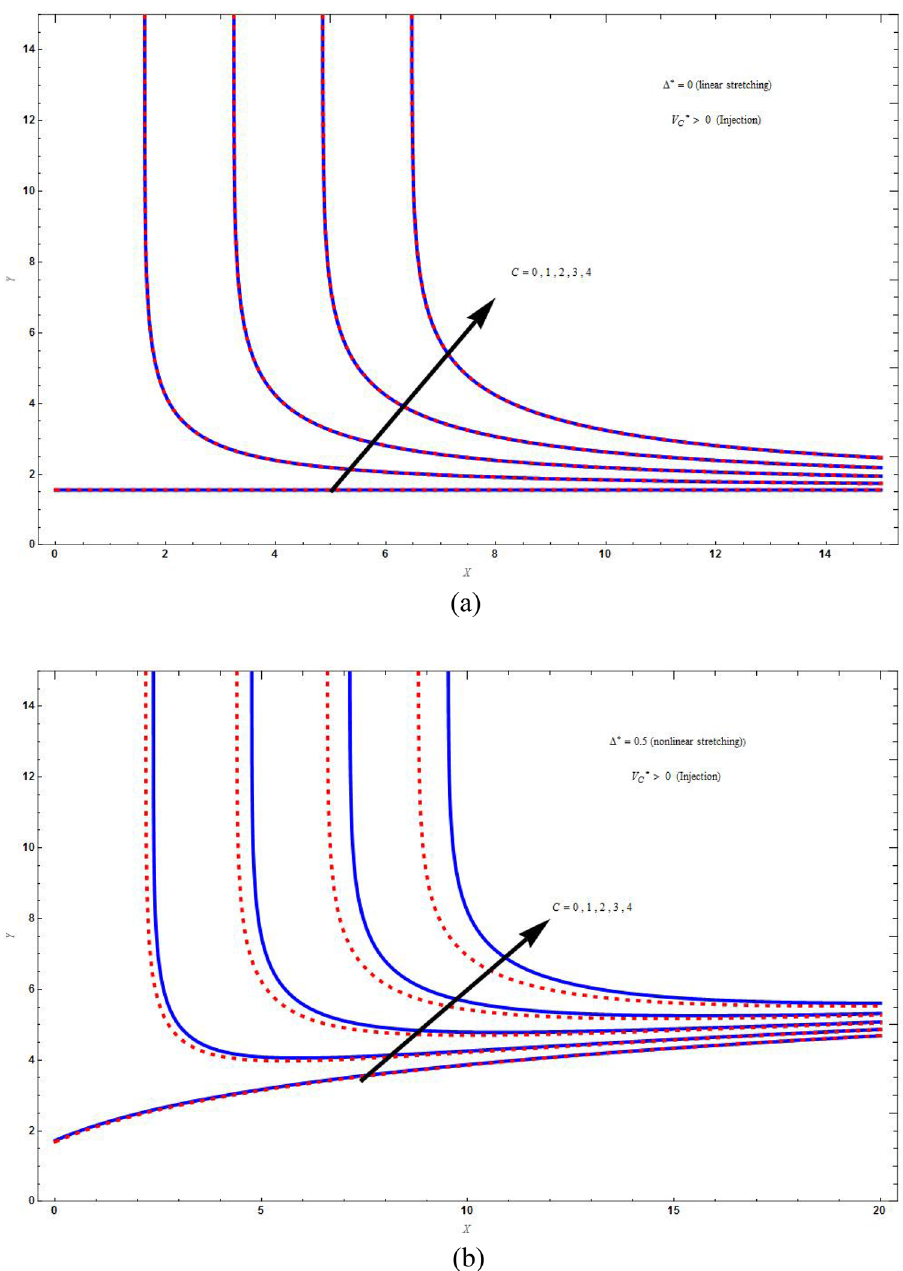
1 V by varying the constant C ( a ) ∗ C = (cid:31) (cid:30)